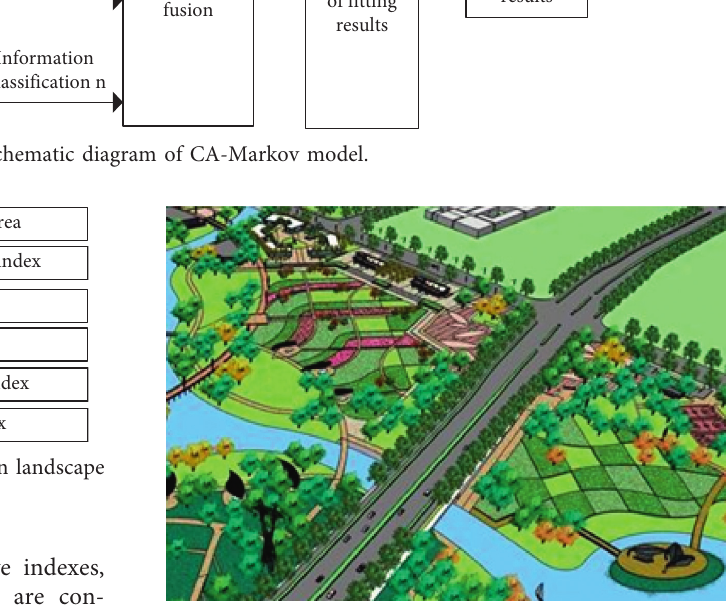
Figure 5: Effect picture of ecological urban landscape pattern.